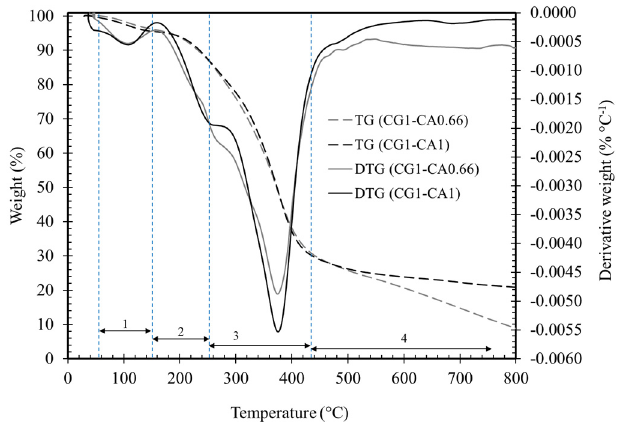
Figure 3. Thermo-gravimetric (TG) and Derivative thermo-gravimetric (DTG) curves of formulations cured at 200 °C for 13 min.